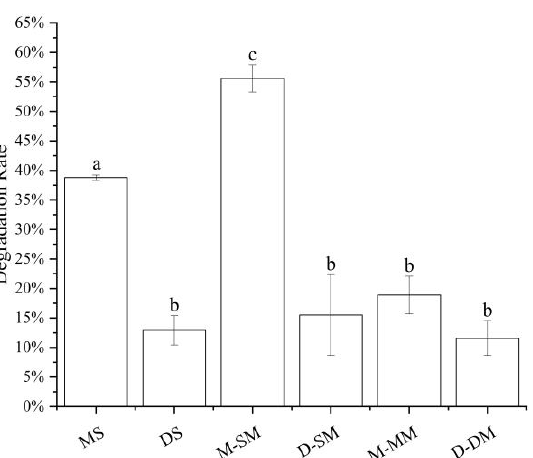
Figure 3. Anthocyanins degradation rates under simulated cell transport conditions. Different small letters indicate significant difference at p < 0.05 in each figure. MS: monoglycoside standard; DS: diglycoside standard; M-: the transport information of monoglycosides; D-: the transport information of diglycosides; SM: standard mixture of monoglycoside and diglycoside; MM: monoglycoside mixture; DM: diglycoside mixture.